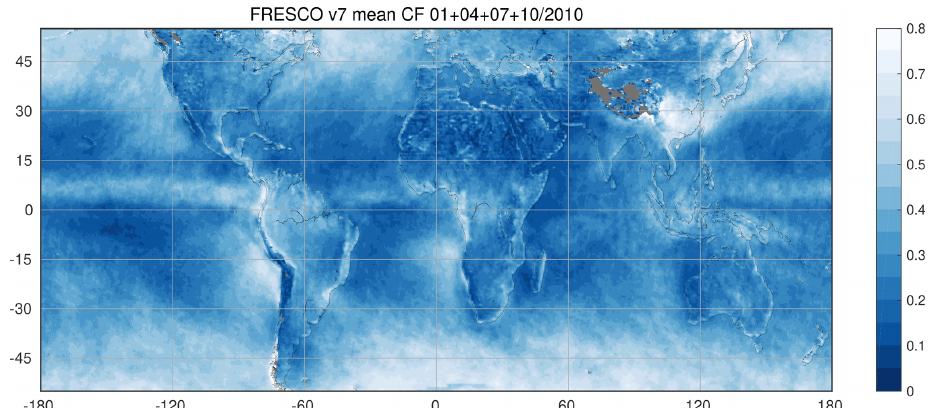
Figure F5. Same as Fig. 14 but showing the 4-month average of the FRESCO v7 cloud fraction measurements recorded in January, April, July, and October 2010. Areas without data are plotted in